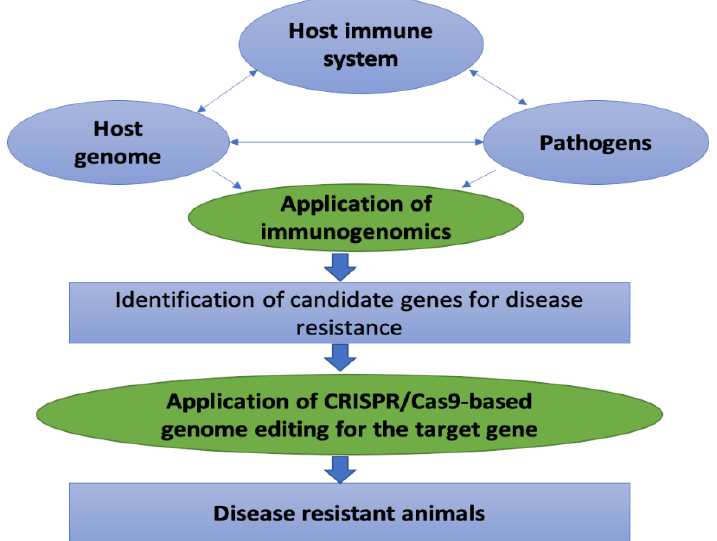
Figure 1. Schematic diagram showing the applications of immunogenomics and genome editing to produce disease-resistant animals. Severity and pathogenesis of disease depend on the interaction of the host immune system and the invading pathogens, where host genetic has potential